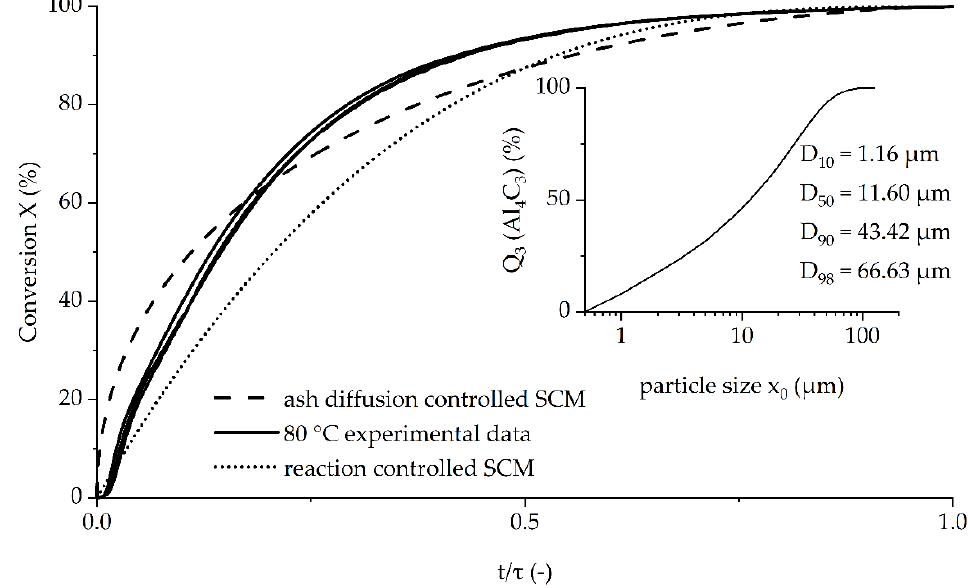
Figure 8. Comparison of a shrinking core model with either ash diffusion control (dashed line) or reaction control (dotted line) with the experimental data obtained at 80 °C. τ represents the time until complete conversion. The inlet depicts the particle size distribution of the Al 4 C 3 powder with a logarithmic x-axis.